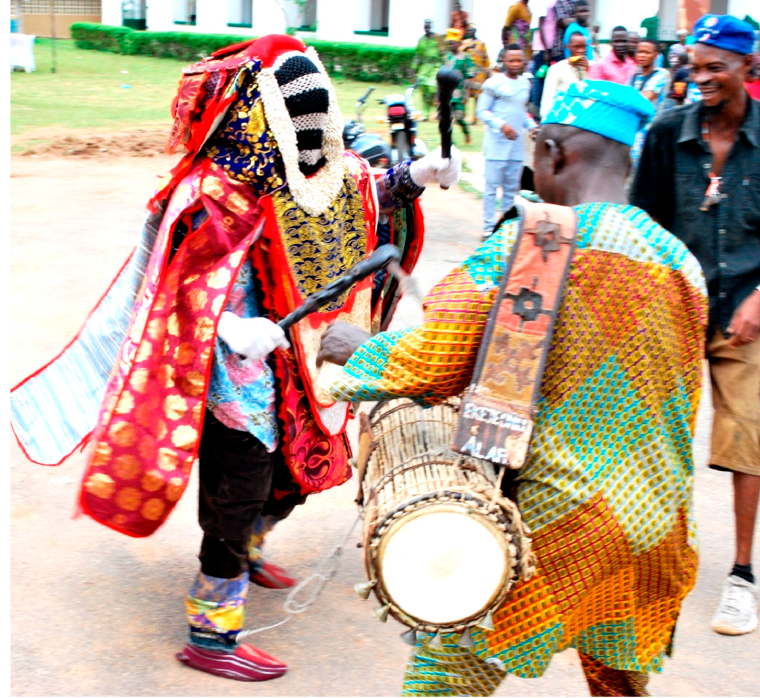
Figure 3. Egúngún Mowuru during the 2018 annual egúngún festival, Òyó. Source: Photograph by Figure 3. Eg ú ng ú n Mowuru during the 2018 annual eg ú ng ú n festival, Ò y ó . Source: Photograph by author.